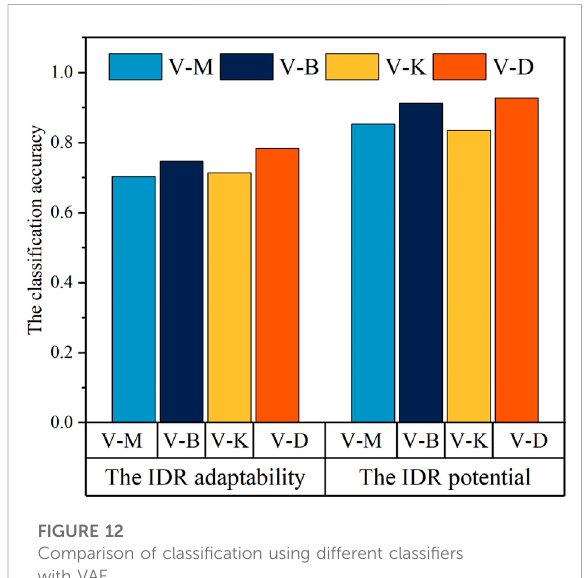
FIGURE 12 Comparison of classi fi cation using different classi fi ers with VAE.